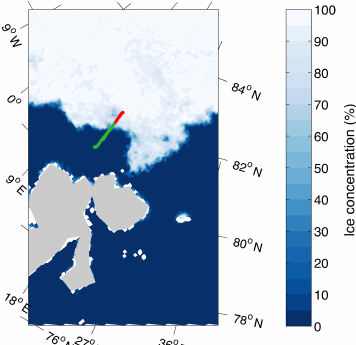
Figure 1. Advanced Microwave Scanning Radiometer (AMSR2) daily sea-ice concentrations (grid resolution 6.25km), from Uni- versity of Bremen, for 23 July 2013. Green line represents the flight track during ACCACIA campaign, between 10:00 and 11:00UTC. Red line shows the flight track at latitudes > 81 . 7 ◦ N; measurements collected along this track are used to evaluate the simulated cloud properties.